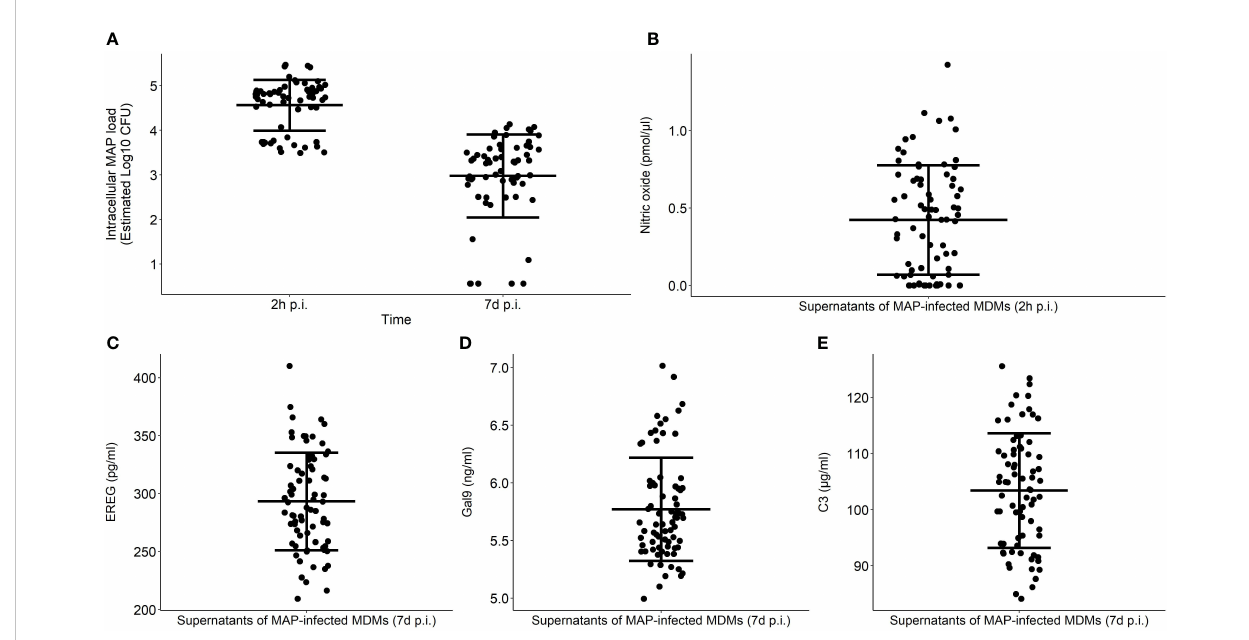
FIGURE 2 Functional phenotyping of bovine MDMs in response to MAP infection. MDMs performance was determined by measuring the intracellular MAP load at 2 h and 7 d p. i. (A) and extracellular NO - (B) , EREG (C) , Gal9 (D) , and C3 production (E) in response to MAP infection. Extracellular NO - levels were measured in the supernatants of MAP-infected MDMs at 2 h p. i. while EREG, Gal9, and C3 production were tested at 7 d p. i. Each dot represents one individual response, the middle line represents the average in each group, and the error bars represent the standard deviation from the mean in each